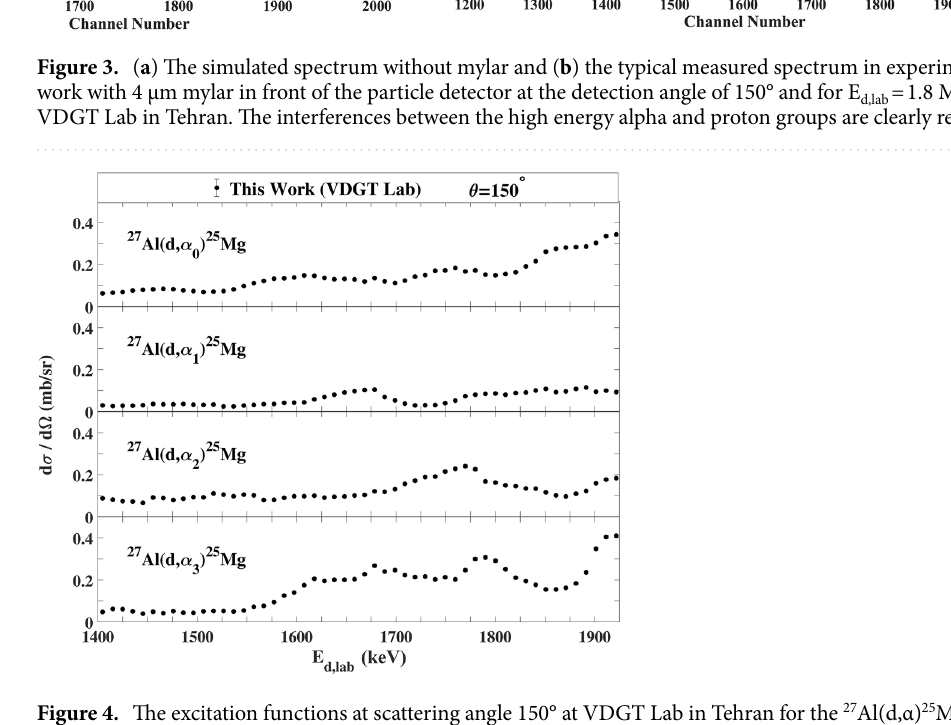
Figure 4. The excitation functions at scattering angle 150° at VDGT Lab in Tehran for the 27 Al(d,α) 25 Mg reactions. The estimated uncertainties from counting statistics are smaller than the plotted